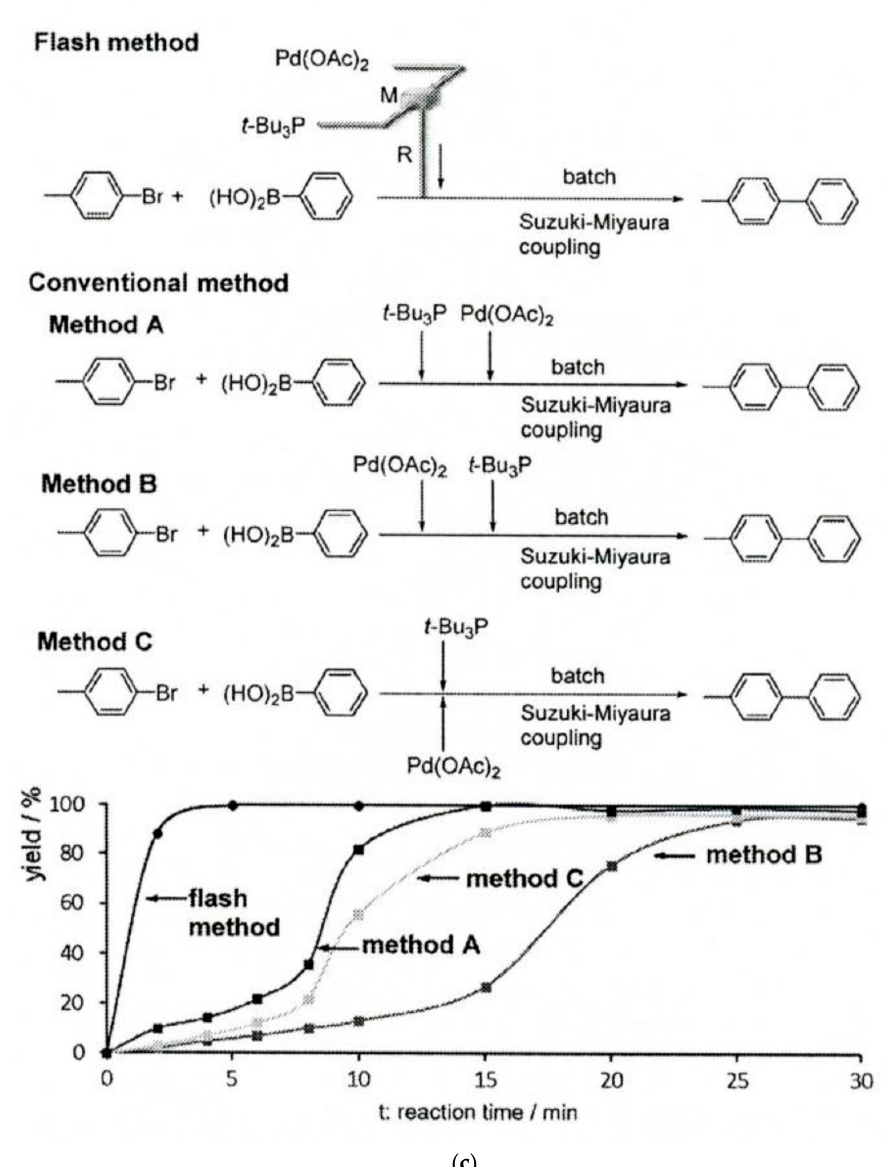
Figure 3. Examples of the kinetic effects for speciation analysis in flow-injection analysis (FIA) systems ( a , b ) and in continuous-flow synthesis ( c ): ( a ) flow-injection signal recorded form a single injection of mixture of sulfide, sulfite, and sulfate into an FIA system with a molecular emission cavity detector [159]; ( b ) manifold of the FIA system (A) and schematic diagram of the sample/ reagent sequencing (B) in the speciation of iron(II) and iron(III), utilizing kinetic discrimination of analytes in the reaction between leucomalachite green (LMG) and persulfate with 1,10-phenan- throline as an activator [162]; ( c ) optimization of continuous-flow synthesis procedure for Suzuki–Miyaura coupling of p -bromo-toluene and phenylboronic acid in the presence of KOH catalyzed by [Pd(OAc) 2 ]- t -Bu 3 P [171].